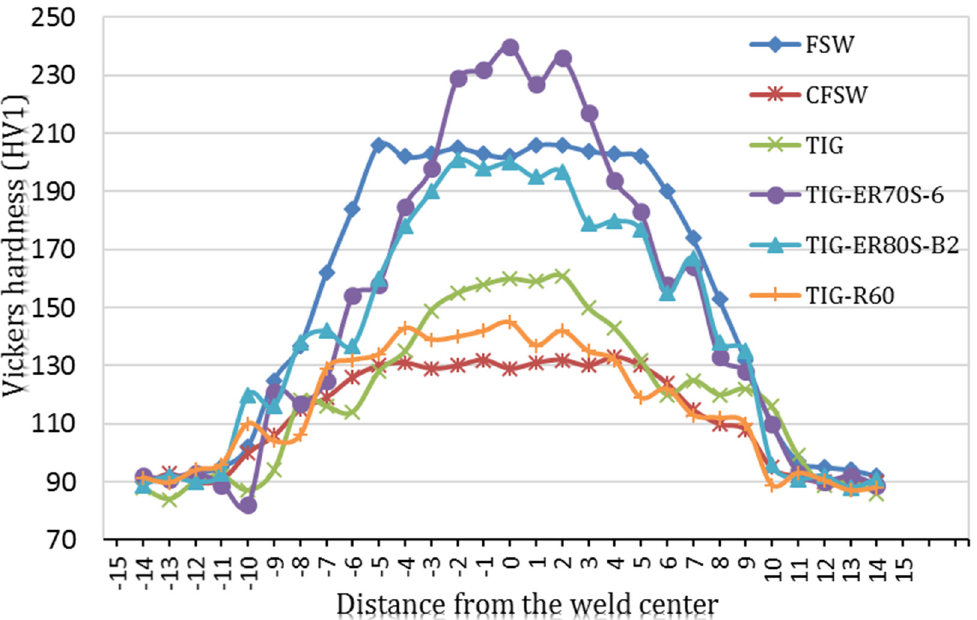
Figure 6. Hardness profiles for both FSW and TIG joints.